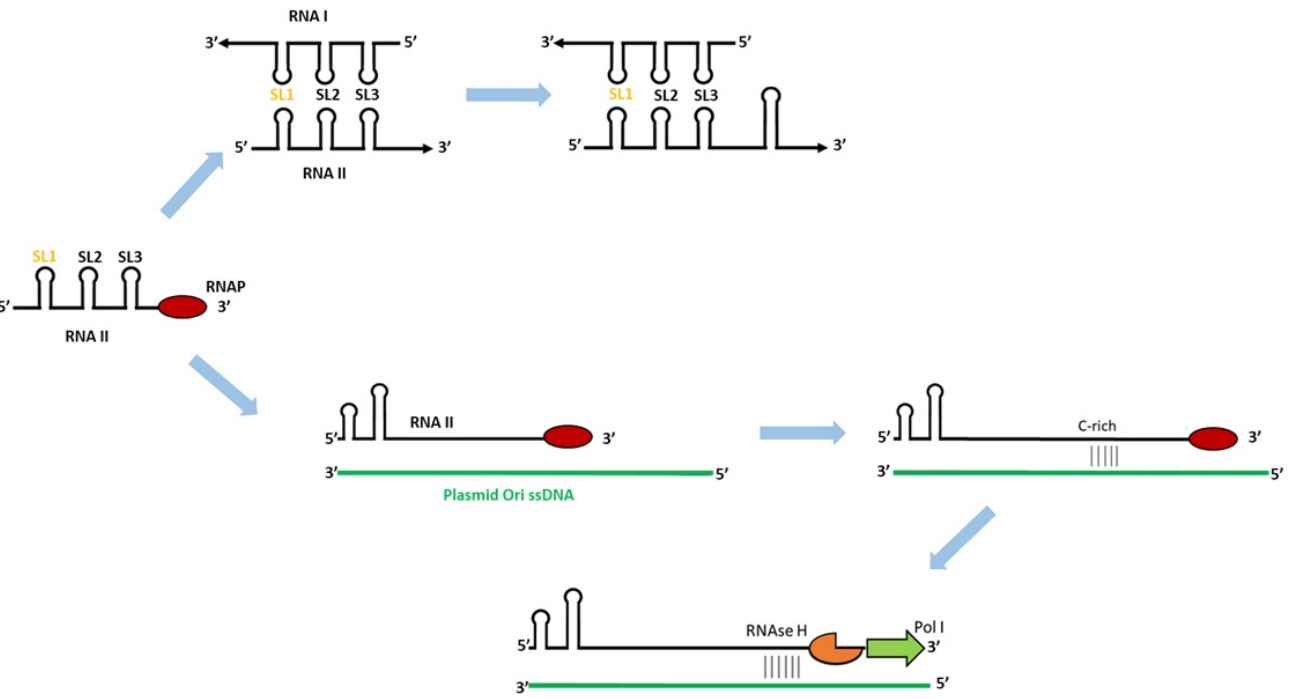
Figure 1. Regulation of replication initiation of ColE1-type plasmids. Plasmid-encoded RNA II (left-most part of the figure) is the pre-primer, synthesized by E. coli RNA polymerase (RNAP, oval), which hybridizes with the plasmid origin (Ori) during transcription (lower part of the figure). This hybridization, strengthened in the C-rich region (due to the formation of C-G pairs in the RNA- DNA hybrid), allows RNase H (fragmentary oval) to cleave the RNA strand hybridized with DNA, thus forming a primer that is used by DNA polymerase I (Pol I, thick arrow) to initiate plasmid DNA synthesis in the replication process (bottom part of the figure). However, ColE1-type plasmid replication initiation is negatively regulated by RNA I, another plasmid-encoded transcript, which interacts with RNA II through stem-loop (SL) structures called SL1, SL2, and SL3 (upper part of the figure). Effective RNA I-RNA II interactions prevent the formation of the RNA II-DNA hybrid despite the appearance of the fourth stem-loop structure in RNA II, thus inhibiting plasmid DNA replication